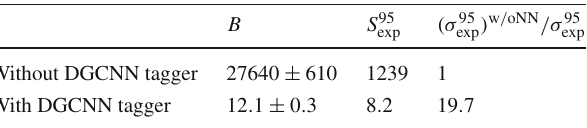
Table 6 Number of background events B with systematic uncertainty in the signal region EM4 of the search with and without the dark shower tagger and corresponding expected 95% CL limit S 95 exp on the number of signal events. In addition, the improvement in the limit on the dark quark production cross section for the benchmark scenario described in the main text is shown relative to the search without a tagger. Table adapted from Ref.